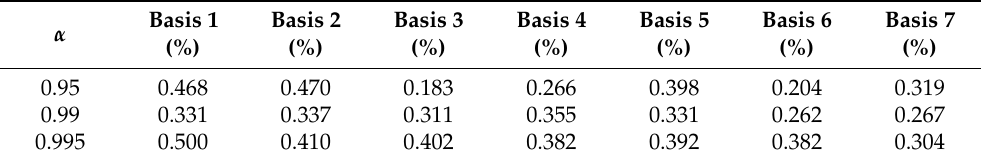
Table 5. The rRMSE of estimated VaR in Portfolio 3.